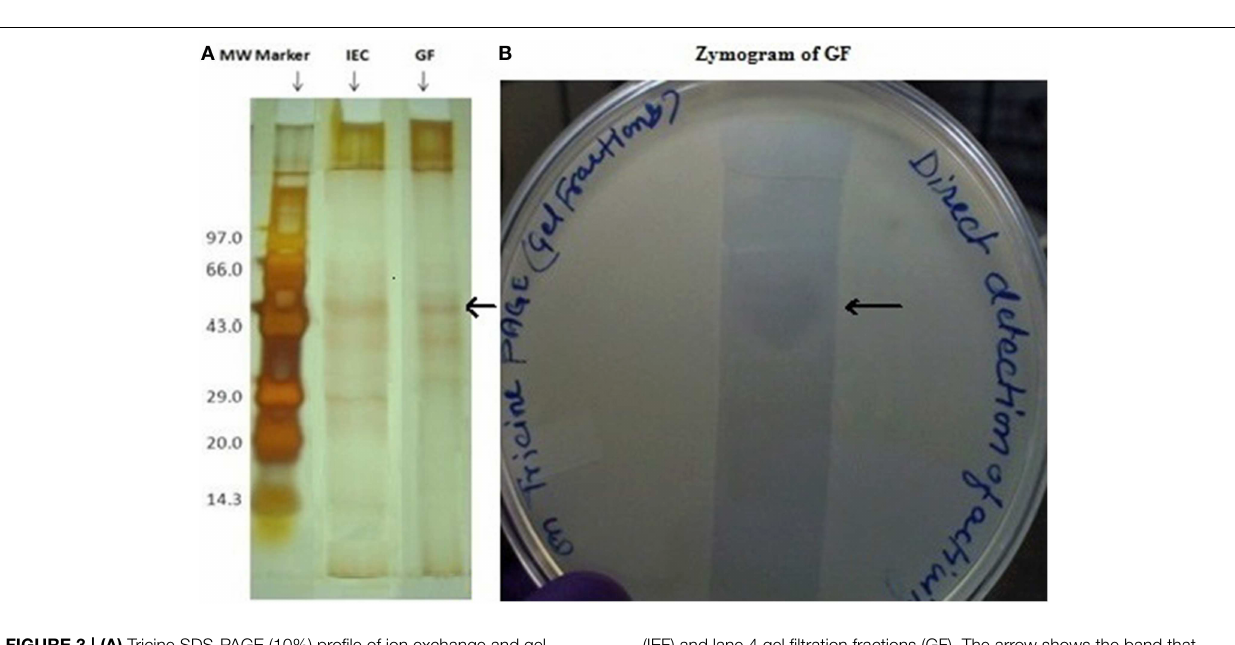
FIGURE 3 | (A) Tricine SDS-PAGE (10%) profile of ion exchange and gel filtration fractions having biological activity in zymogram. Lane1 (from left) shows the molecular weight marker, lane 3 pooled ion exchange fractions